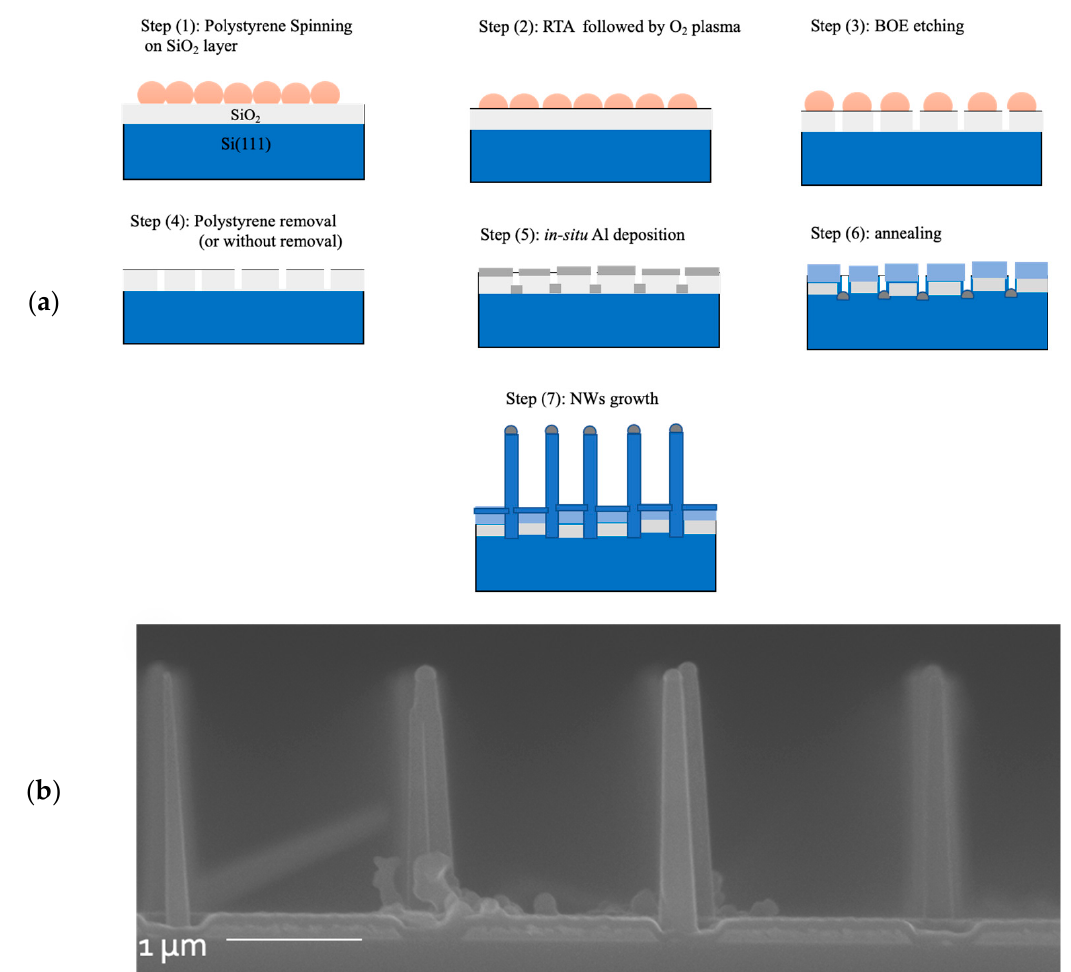
templating in 6 main steps. ( b ) SEM micrograph of grown Si (NWs) using NCT. See the layers between Si-NWs—the bright layer is SiO 2 , which is the top surface of it that is oxidized, forming Al 2 O 3 , covered by the dark layer of planar growth of